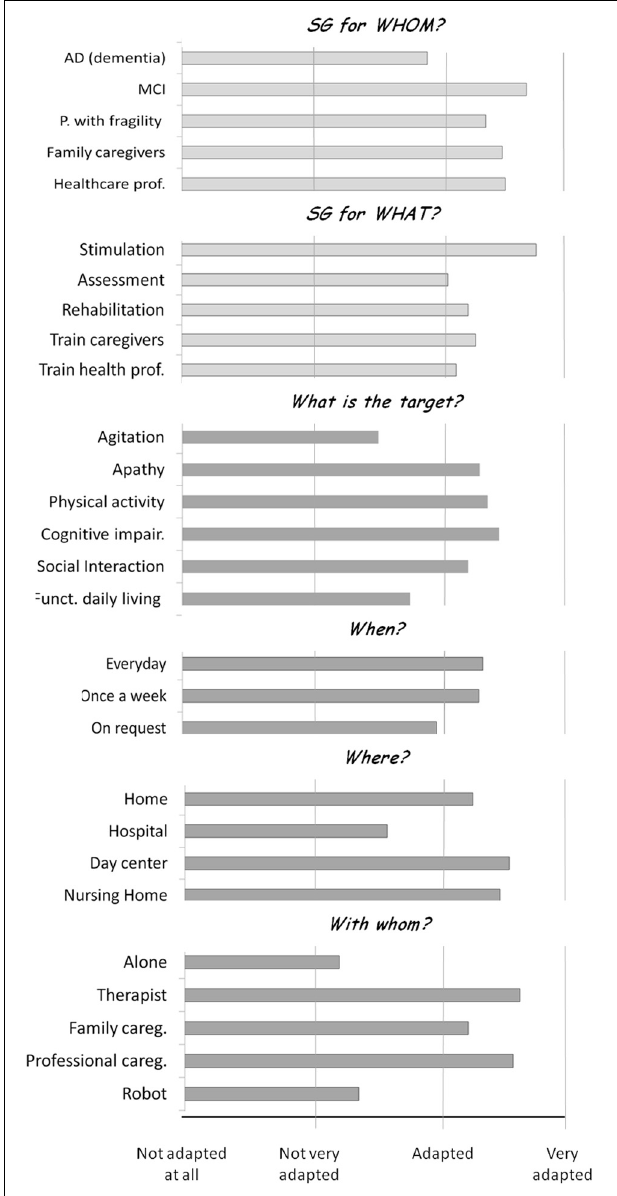
FIGURE 1 | Results of the recommendation questions. Mean ratings provided by participants of round 1 of the recommendation session and participants of the online survey to the two general questions (light gray) and the four questions focused on ADRD (dark gray). Rating scale: 0–3 scale (0, not adapted at all; 1, not very adapted; 2, adapted; 3, very adapted).